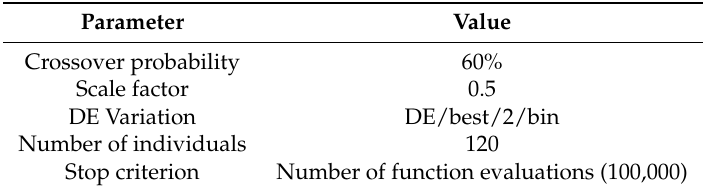
Table 4. Configuration employed in the differential evolution for the DOP of the DRTO.